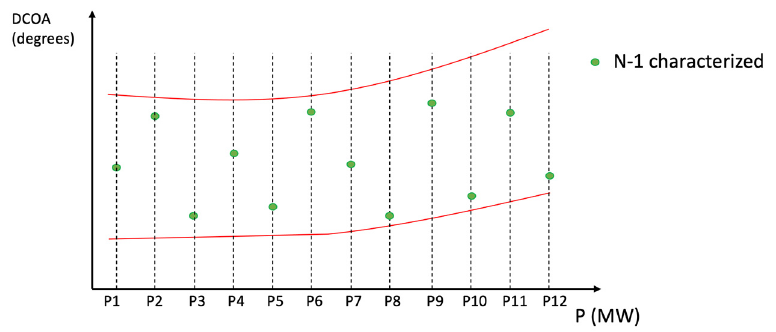
Figure 8. Determination of angular thresholds for a demand scenario with contingencies N-1.